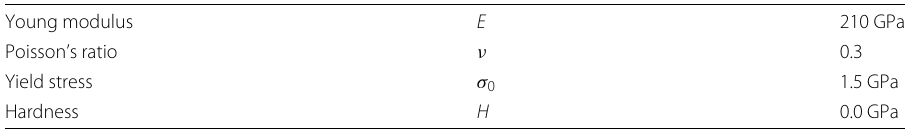
Fig. 7 Stress–strain curve of a linear elastic-ideally plastic material Table 2 Material properties used for both the reference for limit load analysis ( H = 0 . 0